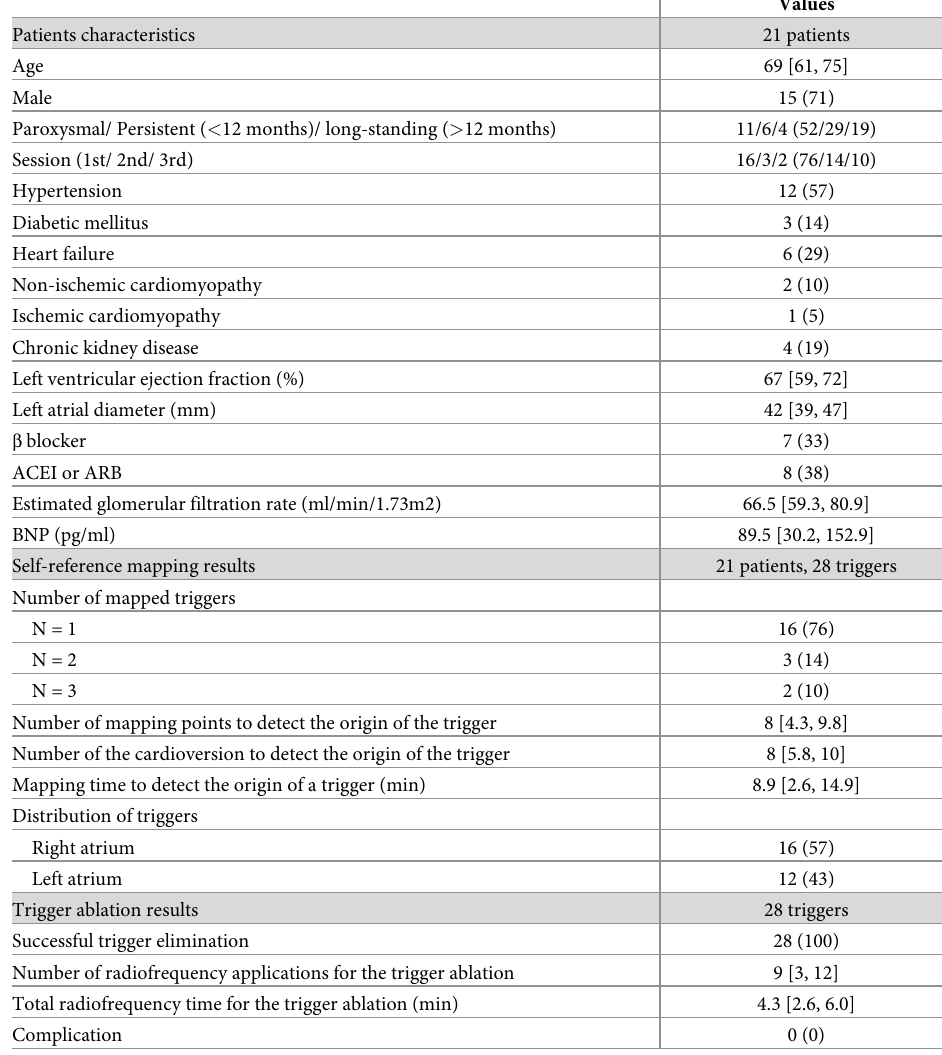
Table 1. Patients characteristics and results of self-reference mapping and